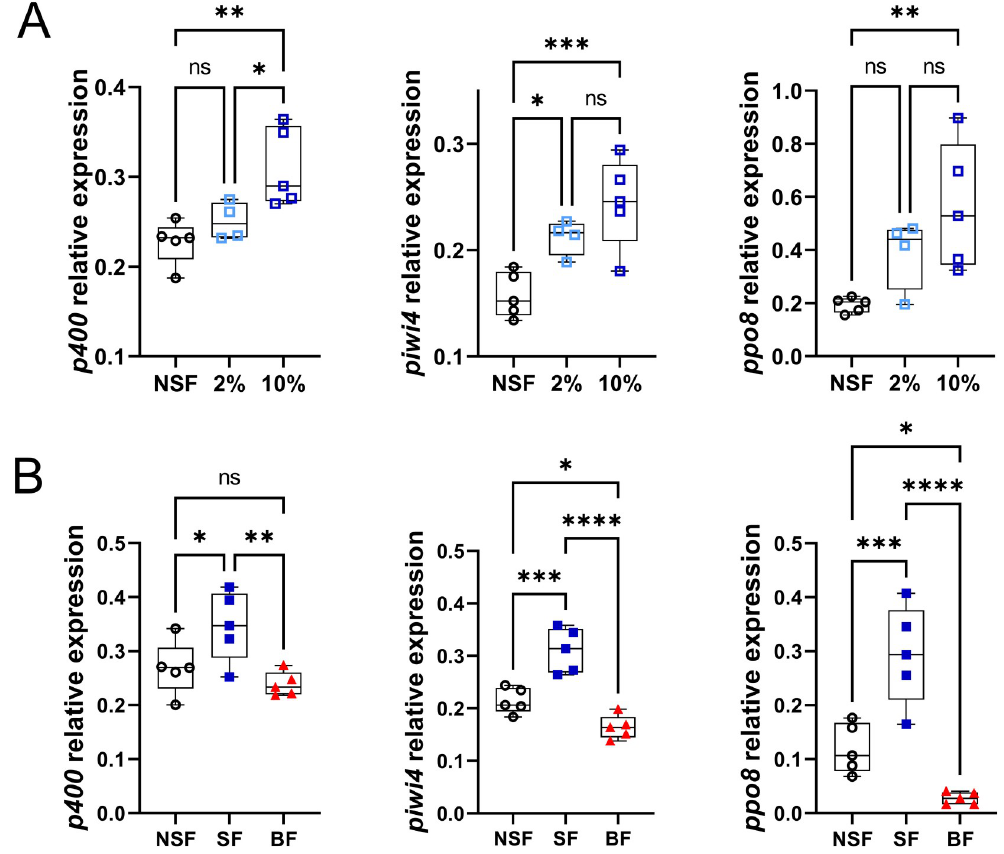
Fig 2. Sucrose feeding-mediated increase of antiviral genes expression level is specific to sucrose. Females were treated as in Fig 1A except that females were (A) either not fed (NSF), fed with 2% sucrose or 10% sucrose, (B) either not fed (NSF), fed with 10% sucrose (SF) or given a blood meal (BF). Digestive tracts were dissected 16 h post sucrose or blood feeding time. RNA transcript levels of p400 , piwi4 and ppo8 were analysed by RT-qPCR. Box plots display the minimum, first quartile, median, third quartile, and maximum relative expression levels. Statistical significance was assessed with an analysis of variance followed by a Fisher’s multiple comparison test. N = 5 pools of 5 digestive tracts per condition. ns, p value > 0.05; � , p value < 0.05; �� , p value < 0.01; ��� , p value < 0.001; ���� , p value <